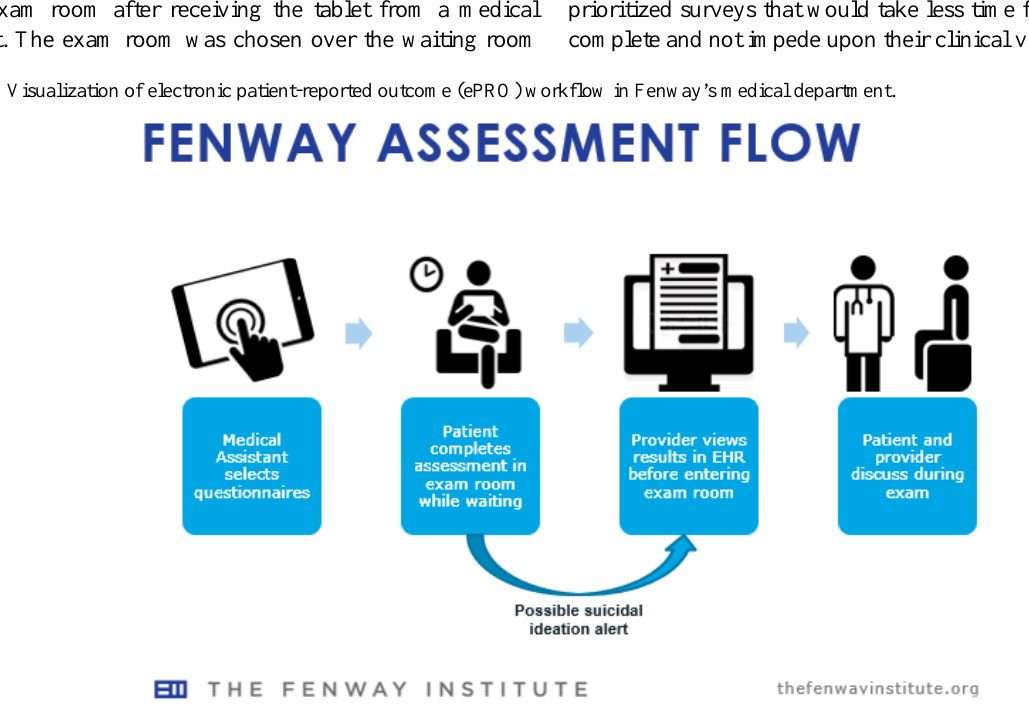
Figure 2. Visualization of electronic patient-reported outcome (ePRO) workflow in Fenway’s medical